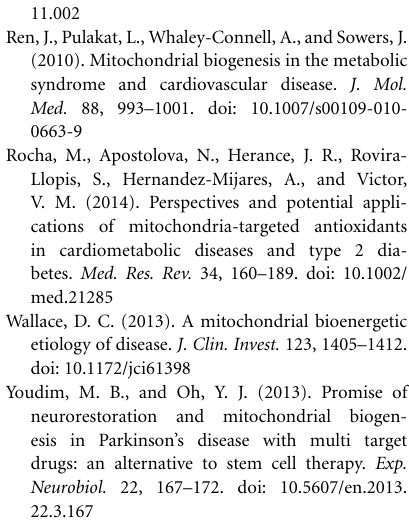
feature utilized by rapidly dividing